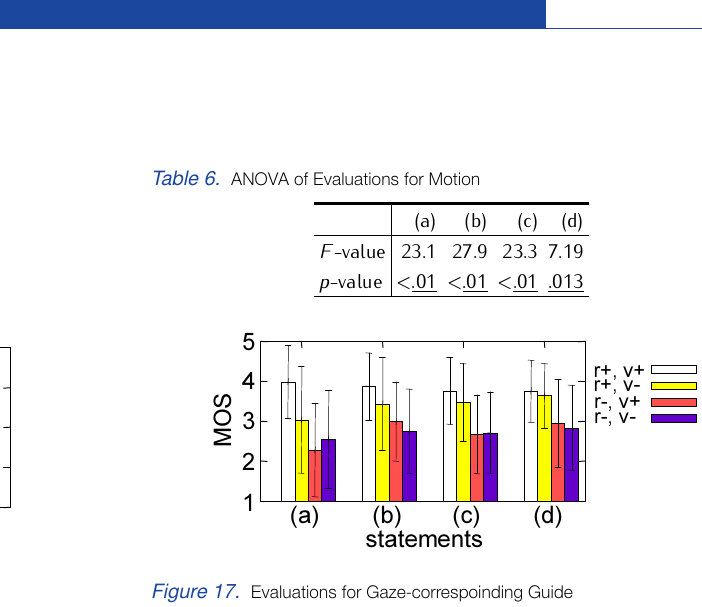
Figure 16. Evaluations for Motion of Joint Attention